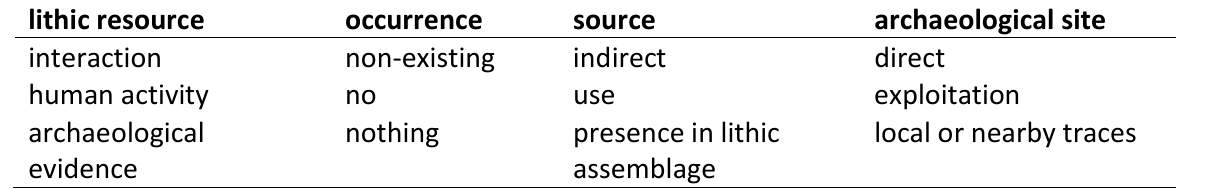
Table 1. Aspects of the human-lithic resource interaction. Table 1. Les aspects de l’interaction humain-resource